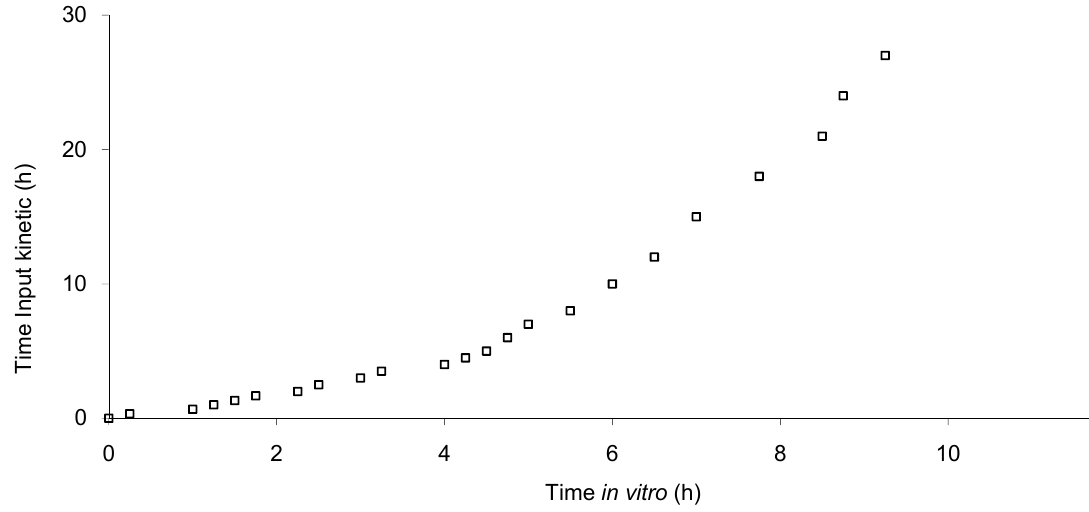
Figure 6. Levy’s plot for time